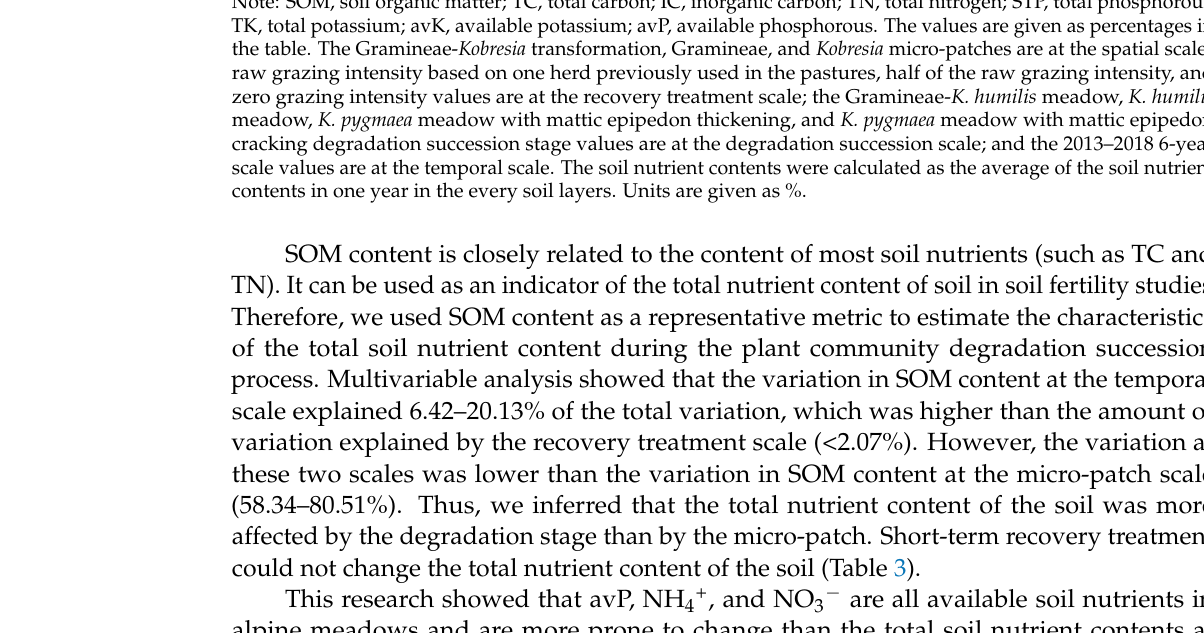
the table. The Gramineae- Kobresia transformation, Gramineae, and Kobresia micro-patches are at the spatial scale.; raw grazing intensity based on one herd previously used in the pastures, half of the raw grazing intensity, and zero grazing intensity values are at the recovery treatment scale; the Gramineae- K. humilis meadow, K. humilis meadow, K. pygmaea meadow with mattic epipedon thickening, and K. pygmaea meadow with mattic epipedon cracking degradation succession stage values are at the degradation succession scale; and the 2013–2018 6-year scale values are at the temporal scale. The soil nutrient contents were calculated as the average of the soil nutrient contents in one year in the every soil layers. Units are given as